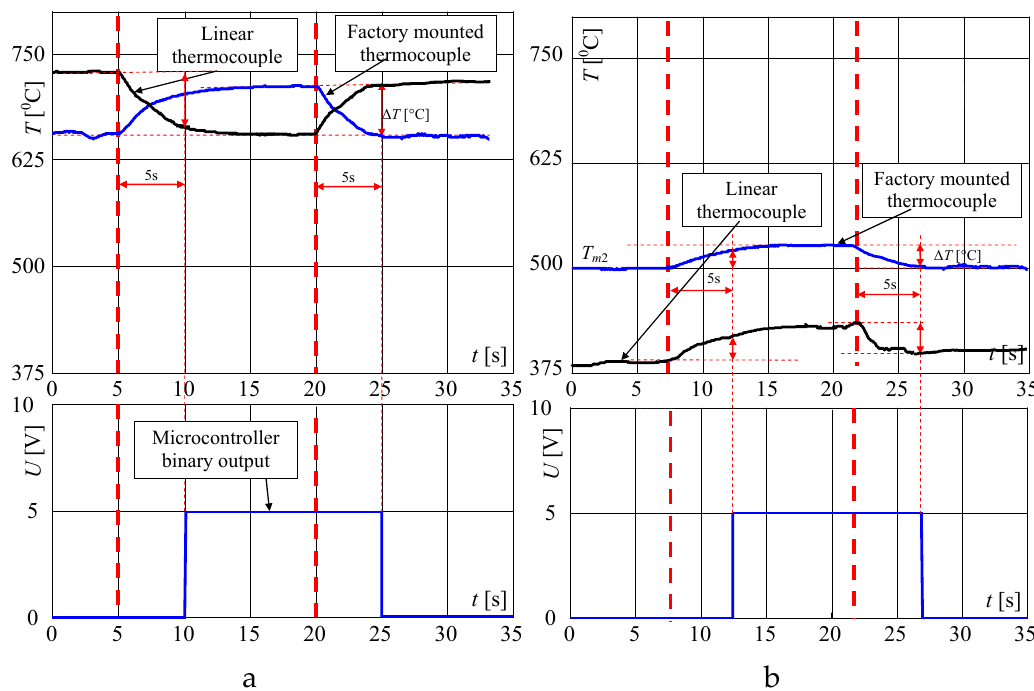
Figure 22. Signal changes measured by both thermocouples for the placing and removing of the pot from a burner if the flame is: ( a ) big, ( b ) small, and microcontroller binary output signal.